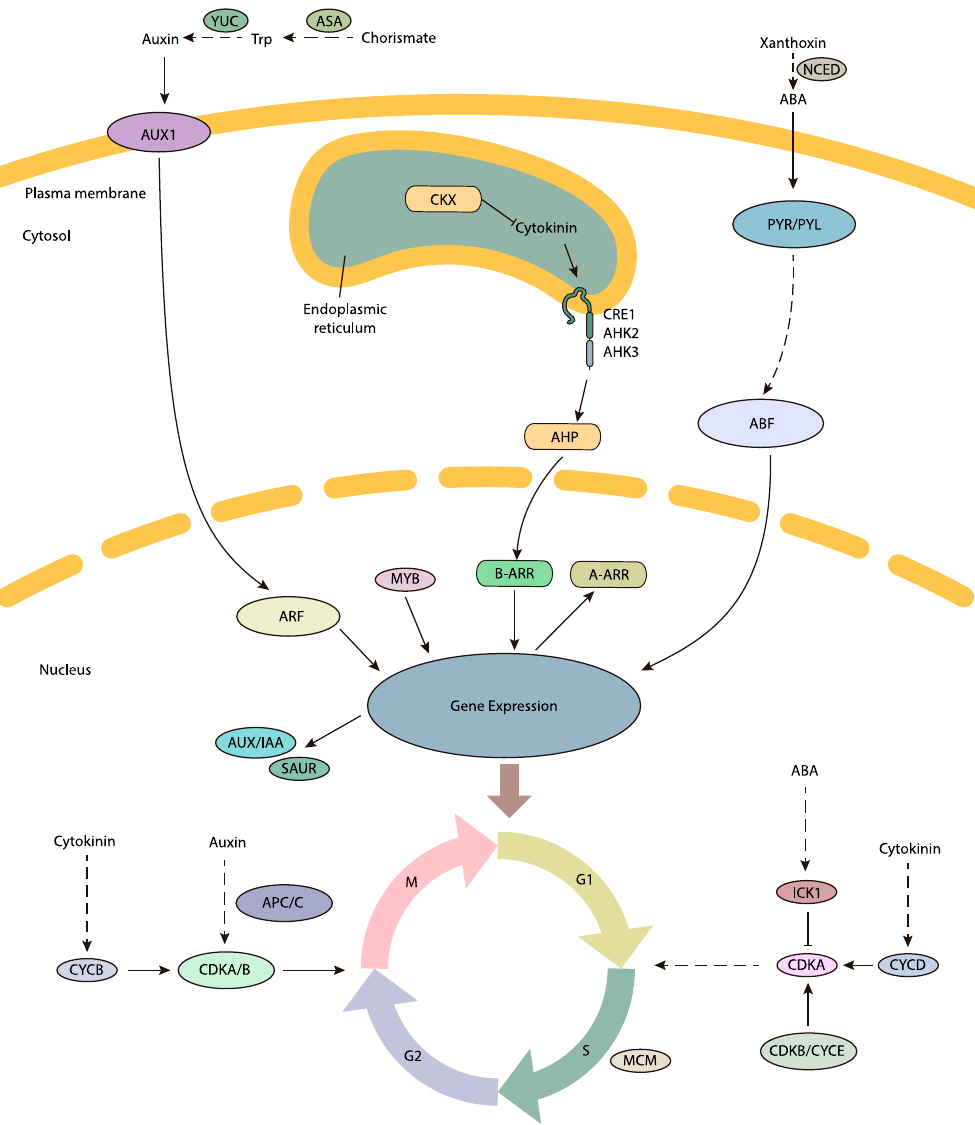
Figure 9. Diagram of the putative regulatory mechanisms of the FNM process. External signals are sensed by FG and may trigger the FNM process. The DEGs, which are found in comparison between developing and abortive ovules, are involved in phytohormone pathways and the cell cycle process. The phytohormone pathway contains the following genes involved in auxin biosynthesis ( YUC and ASA ), auxin signal transduction ( AUX1 , ARF , AUX/IAA and SAUR ), cytokinin degradation ( CKX ) and signal transduction ( CER1/AHK , AHP and A-ARR ), ABA biosynthesis ( NCED ) and signal transduction ( PYR/PYL and ABF ). The gene expression may also regulate the cell cycle process by up- or down-regulated key genes, such as genes encoding CDKB, ICK1, APC/C and MCM proteins. The line arrow indicates direct interaction between subjects. The dot line arrow suggests the indirect influence or abbreviated multi-step between two subjects. ABF, ABA responsive element binding factor; AHK, Arabidopsis histidine kinase; AHP, Arabidopsis histidine phosphotransfer protein; ARF, auxin response factor; AUX1, AUXIN1; APC/C, anaphase-promoting complex/cyclosome; ASA, anthranilate synthase; CDK, cyclin-dependent kinase; CKX, cytokinin oxidases/dehydrogenases; CRE1, cytokinin response 1; CYC, cyclin; ICK, CDK inhibitory protein; MCM, minichrome maintenance; NCED, 9- cis -Epoxycarotenoid dioxygenase; PYL, PYR1-Like protein; PYR, pyrabactin resistance 1 protein; SAUR, small auxin-up RNA; YUC,